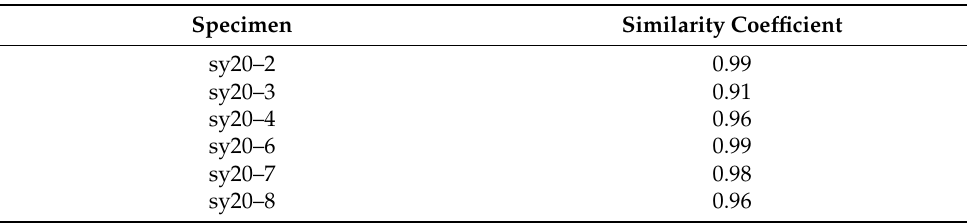
Table 1. The similarity coefficients of the radiance increment spectra of six sandstone samples and the average spectrum with extensional fissures.